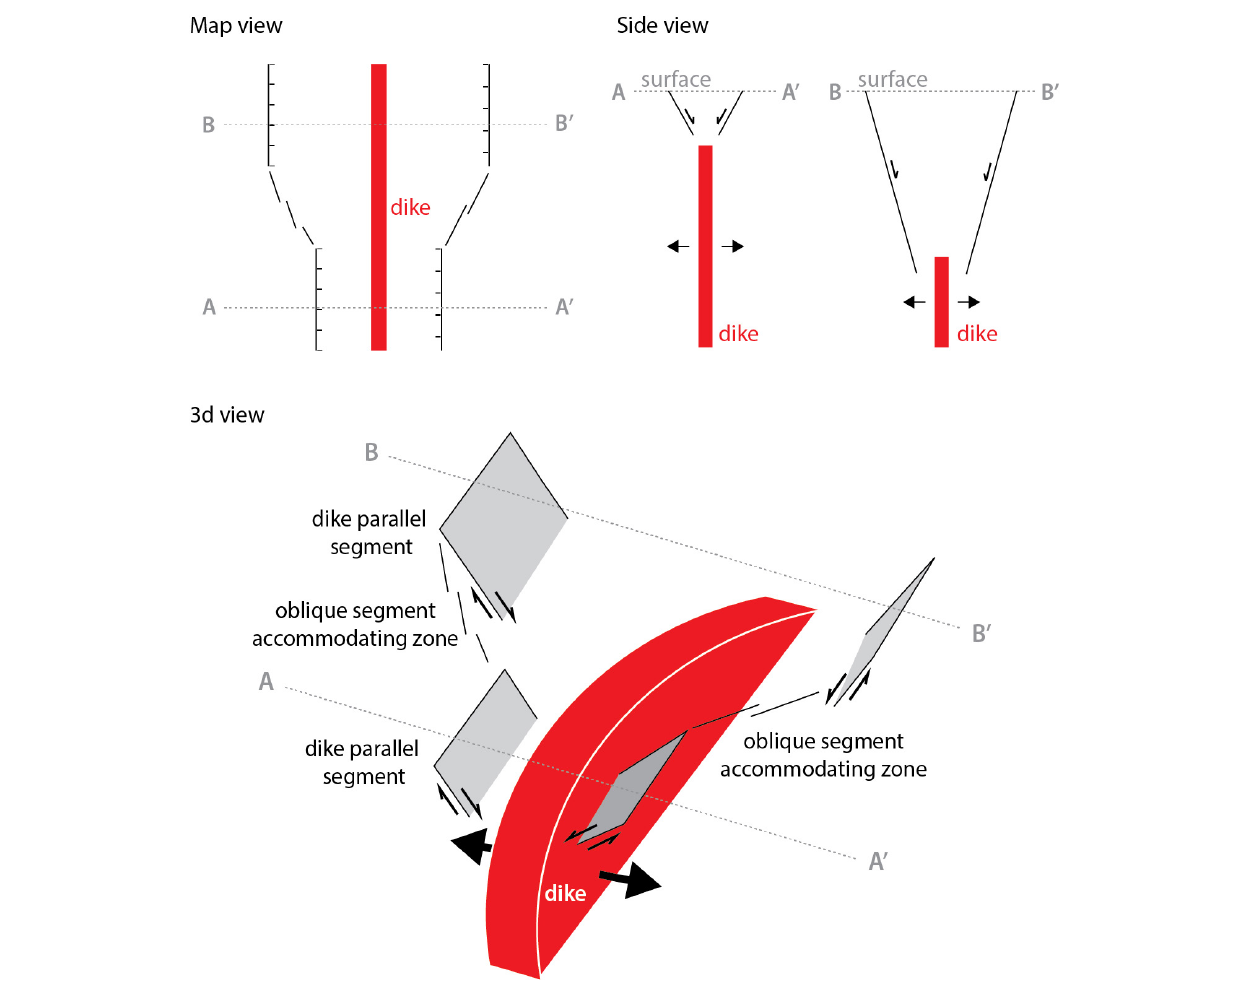
FIGURE 12 | Schematic model showing the relationships between dike depth and new or reactivated tectonic segments both parallel and oblique to the dike strike. The top of the dike is arc shaped (3D view) with its upper tip at shallower depth under profile A-A (cid:48) than under profile B-B (cid:48) (side view panel). Shallow dike tips induce narrow grabens at the surface, while deep tips cause wide grabens, resulting in horizontal shifts between dike parallel segments, connected by oblique segments (map view panel). The oblique segments form an accommodation zone between the shifted dike parallel segments.